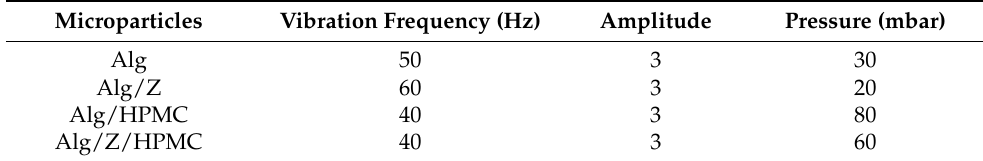
Table 1. Encapsulation